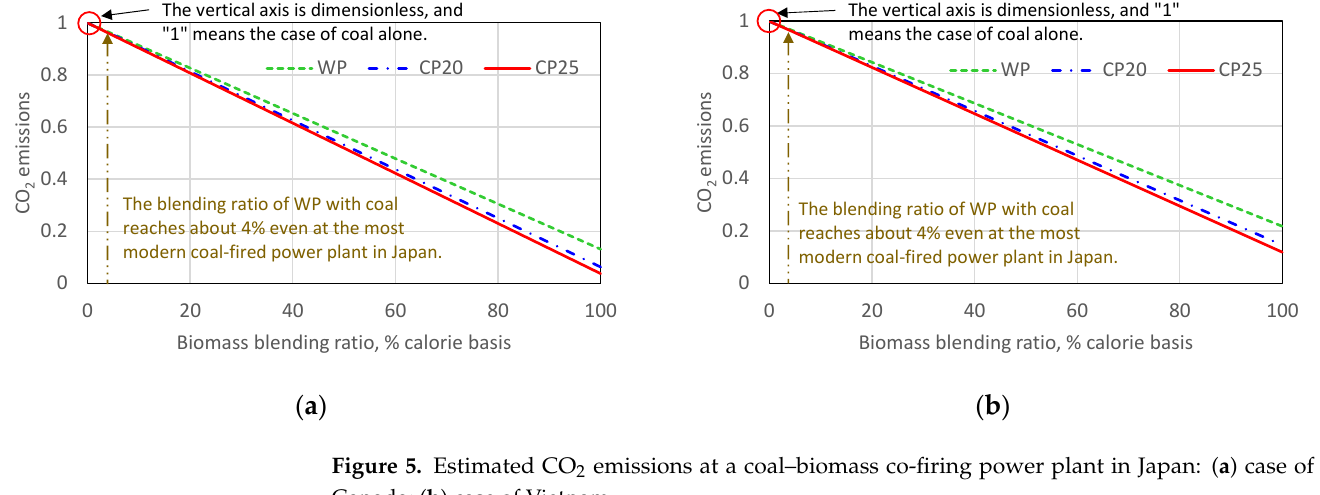
Figure 5. Estimated CO 2 emissions at a coal–biomass co-firing power plant in Japan: ( a ) case of Canada; ( b ) case of Vietnam.